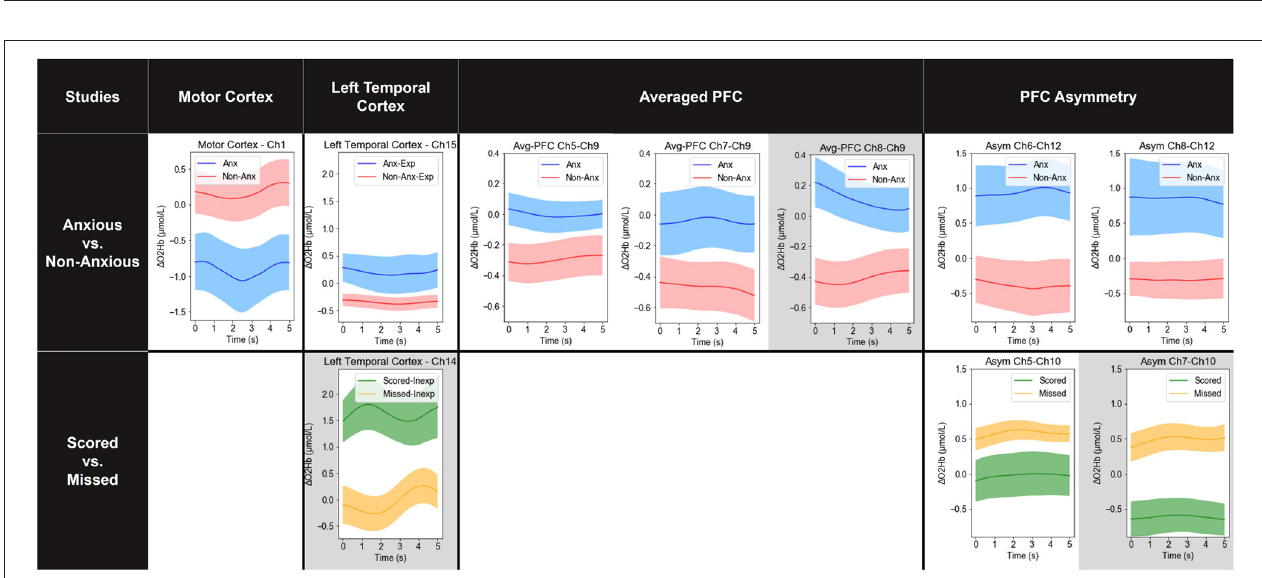
FIGURE 5 | Averaged features across all trials from all participants where the difference between two conditions in a specific study, regarding experience, anxiety, and success/failure, are significant at p < 0.05 (uncorrected). Features are shown in the variation over a 5-s waiting period. Note that the studies of anxiety and success/failure in the left temporal cortex were done separately by groups of experience [experienced (Exp) and inexperienced (Inexp) players]. Results that remain statistically significant at p < 0.05 after FDR correction are with a gray